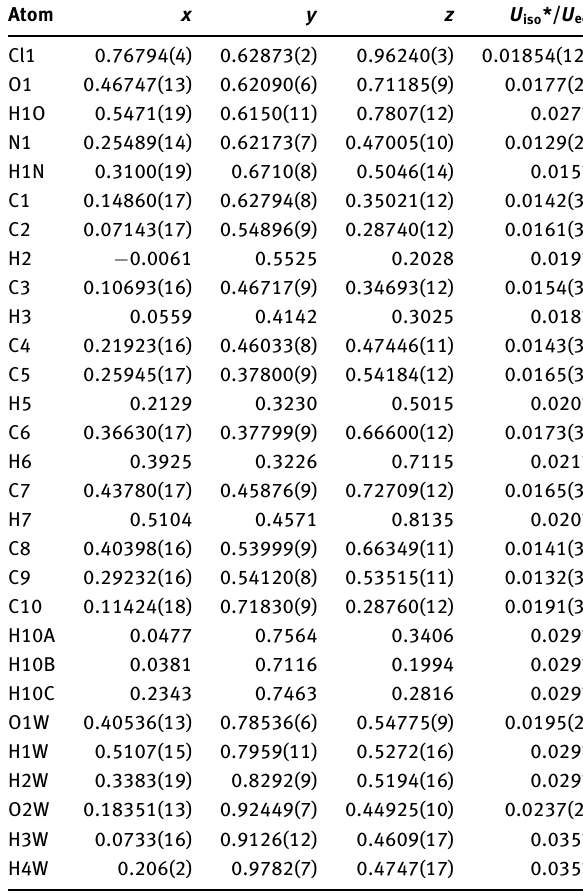
Table 2: Fractional atomic coordinates and isotropic or equivalent isotropic displacement parameters (Å 2